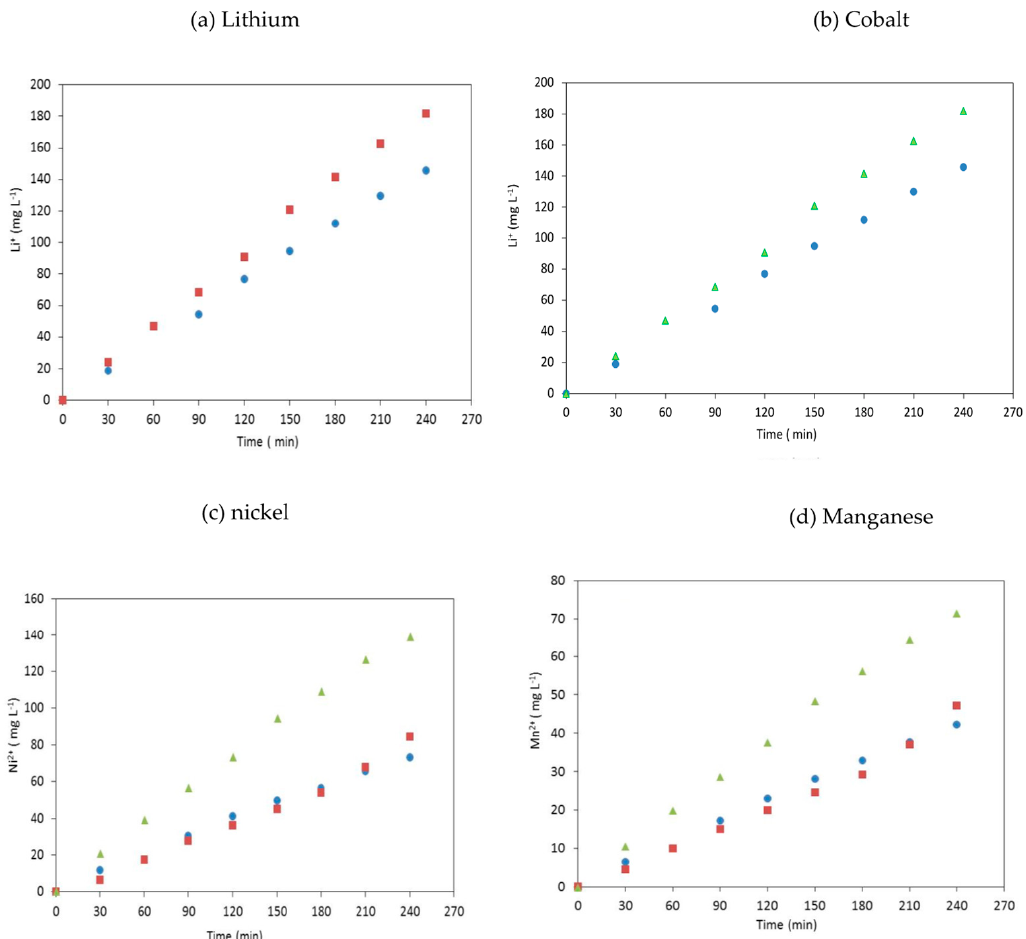
Figure 3. Evolution of metal concentrations in the recovery compartment as a function of time at j = 10 mA cm − 2 (blue circle), 12.5 mA cm − 2 (red square) and 15 mA cm − 2 (green triangle) with the ED configuration 2 reported in Figure 1c (Anodic and cathodic compartments = 0.1 M H 2 SO 4 ; concen ‐ trate solution = 0.0025 M H 2 SO 4 ( 𝛔 = 2.27 mS cm − 1 , pH = 2.4) when j = 10 mA cm − 2 ; Li 2 SO 4 (5 g L − 1 Li + ) in 0.0025 M H 2 SO 4 ( 𝛔 = 38.83 mS cm − 1 pH = 2.82) when j = 12.5 mA cm − 2 ; 0.0025 M H 2 SO 4 ( 𝛔 = 2.24 mS cm − 1 , pH = 2.3) when j = 15 mA cm − 2 ; Neosepta ® monovalent ‐ selective cationic exchange mem ‐ brane; The pH value in the leaching solution decreased from 2.8 to 2.3 but it remained almost con ‐ stant and equal to 2.3 in the concentrate for all current densities).